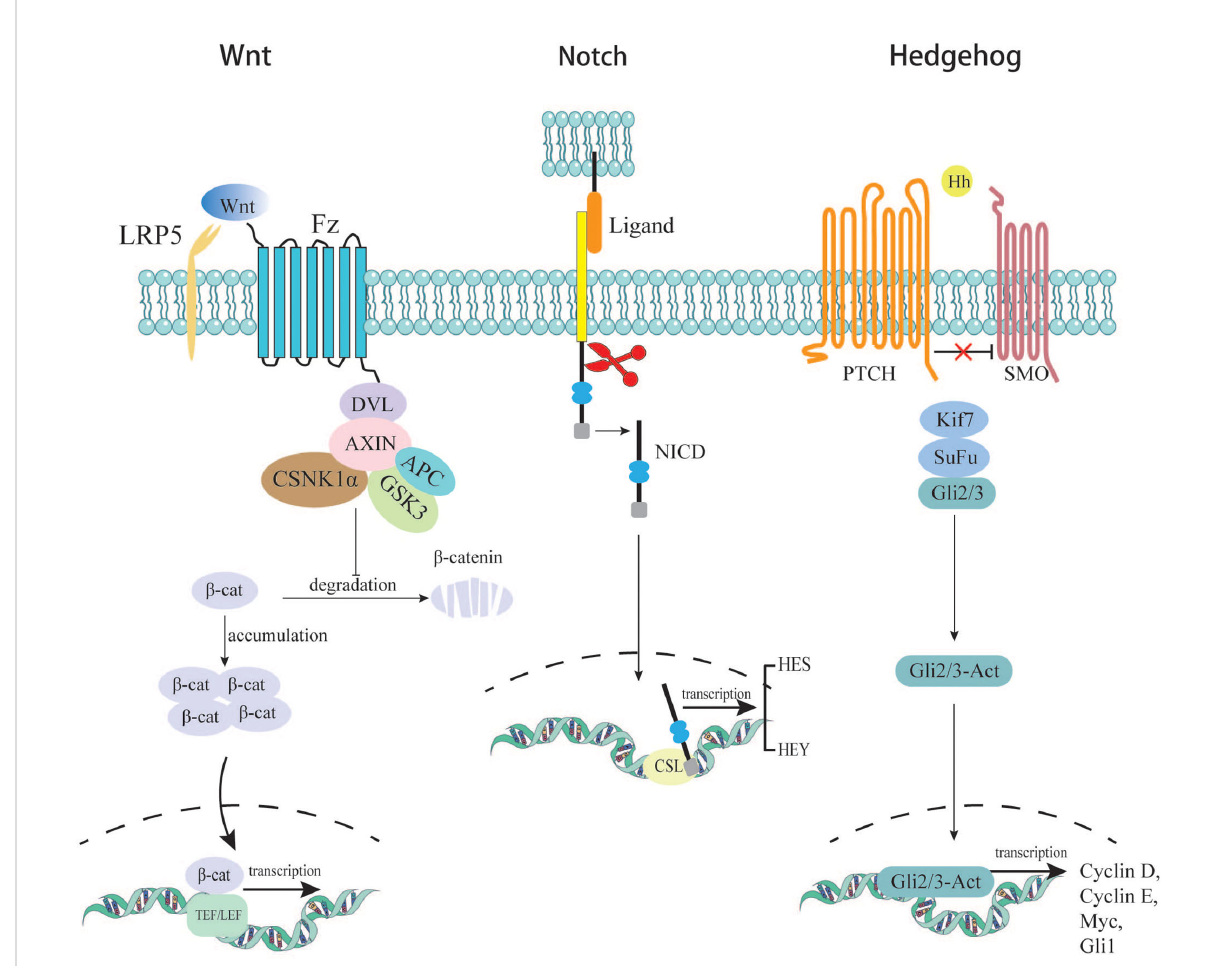
FIGURE 2 Several signaling pathways related to acquisition of cancer cell